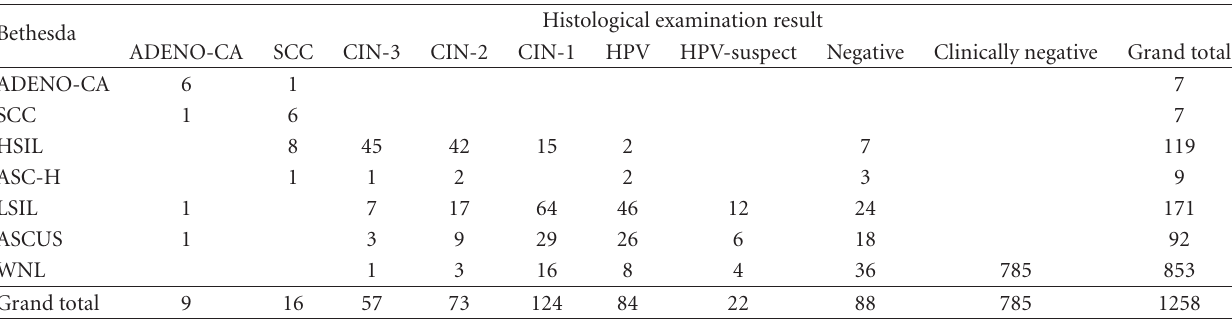
Table 2: Cross-tabulation of the histological and cytological findings.